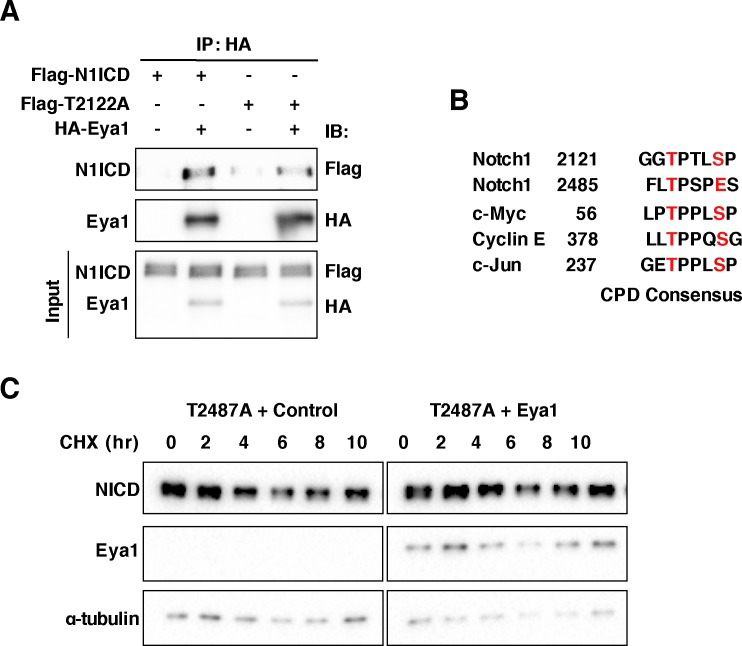
Eya1 does not affect the T2487 phosphorylation site of Notch1 ICD, related to Figure 7.(A) Co-immunoprecipitation analysis of 293T cells transfected with indicated cDNAs. Pull-down assays using anti-HA antibody and immunoblot with anti-Flag and anti-HA. Input was 5% of the amount of proteins used for IP. (B) Sequence alignment of Notch1 with c-Myc, Cyclin E and c-Jun. The alignment revealed two sites on Notch1, T2122 and T2487, which are similar to other Fbw7 substrates with the Cdc phosphodegrons (CPDs) consensus motif. (C) Notch1 ICD protein stability analysis. 293T cells transfected with indicated plasmids were treated with cycloheximide (CHX). At indicated time points, cells were lysed and examined by immunoblotting with anti-Notch1 ICD (V1744), anti-Flag, or anti-α-tubulin (loading control) antibodies. The results showed that Notch1 ICDT2487A mutant was more stable than WT Notch1 ICD, while Eya1 did not affect the stability of this mutant, indicating that T2487 may not be a target site of Eya1 (n = 3).